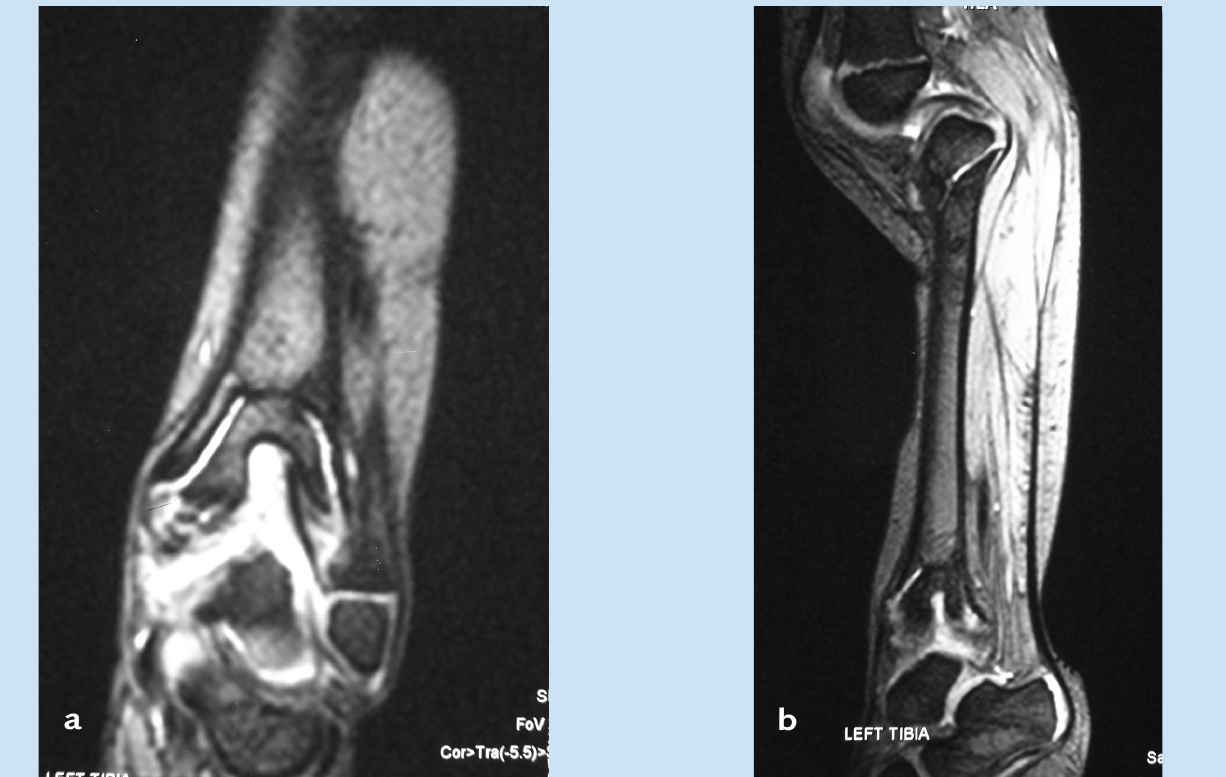
Fig. 2. Postmeningococcal physeal bar. (a) This gradient echo sequence demonstrates a distal tibial physeal bar that is central and results in a ‘tenting’ deformity of the epiphysis. (b) A sagittal image in the same patient shows the distal and proximal tibial physes revealing a second bar at the anterior portion of the proximal tibial physis.